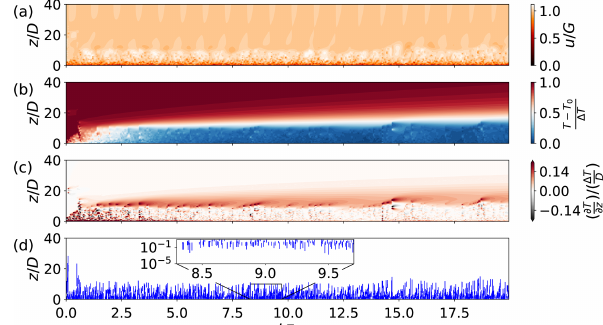
Figure 5. Hovmöller diagrams of various observables showing the temporal evolution of the momentum and thermal boundary layer for a single ODT realization of the weakly stratified case W001 with Re = 500 and Fr = 1000. (a) Momentary velocity component u ( z,t ), (b) momentary temperature T ( z,t ), (c) momentary tempera- ture gradient [ ∂T/∂z ] ( z,t ), and (d) sequence of implemented ODT eddy events visualized by instantaneous vertical line intervals. In each plot the vertical coordinate has been truncated for